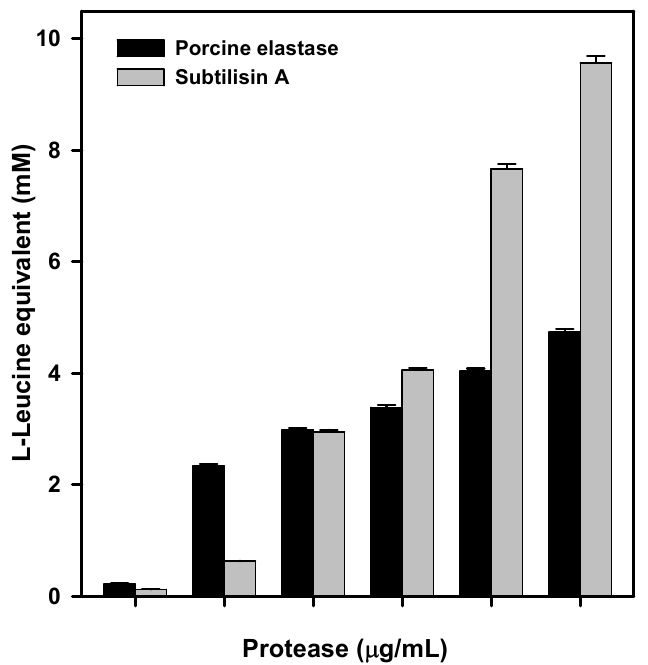
Figure 5. L-Leucine equivalent (mM) release after incubation (37 °C/24 h) of raw silk with different amounts of the commercial protease porcine elastase and B. licheniformis subtilisin A. The results shown are the average of two different experiments performed in triplicate.